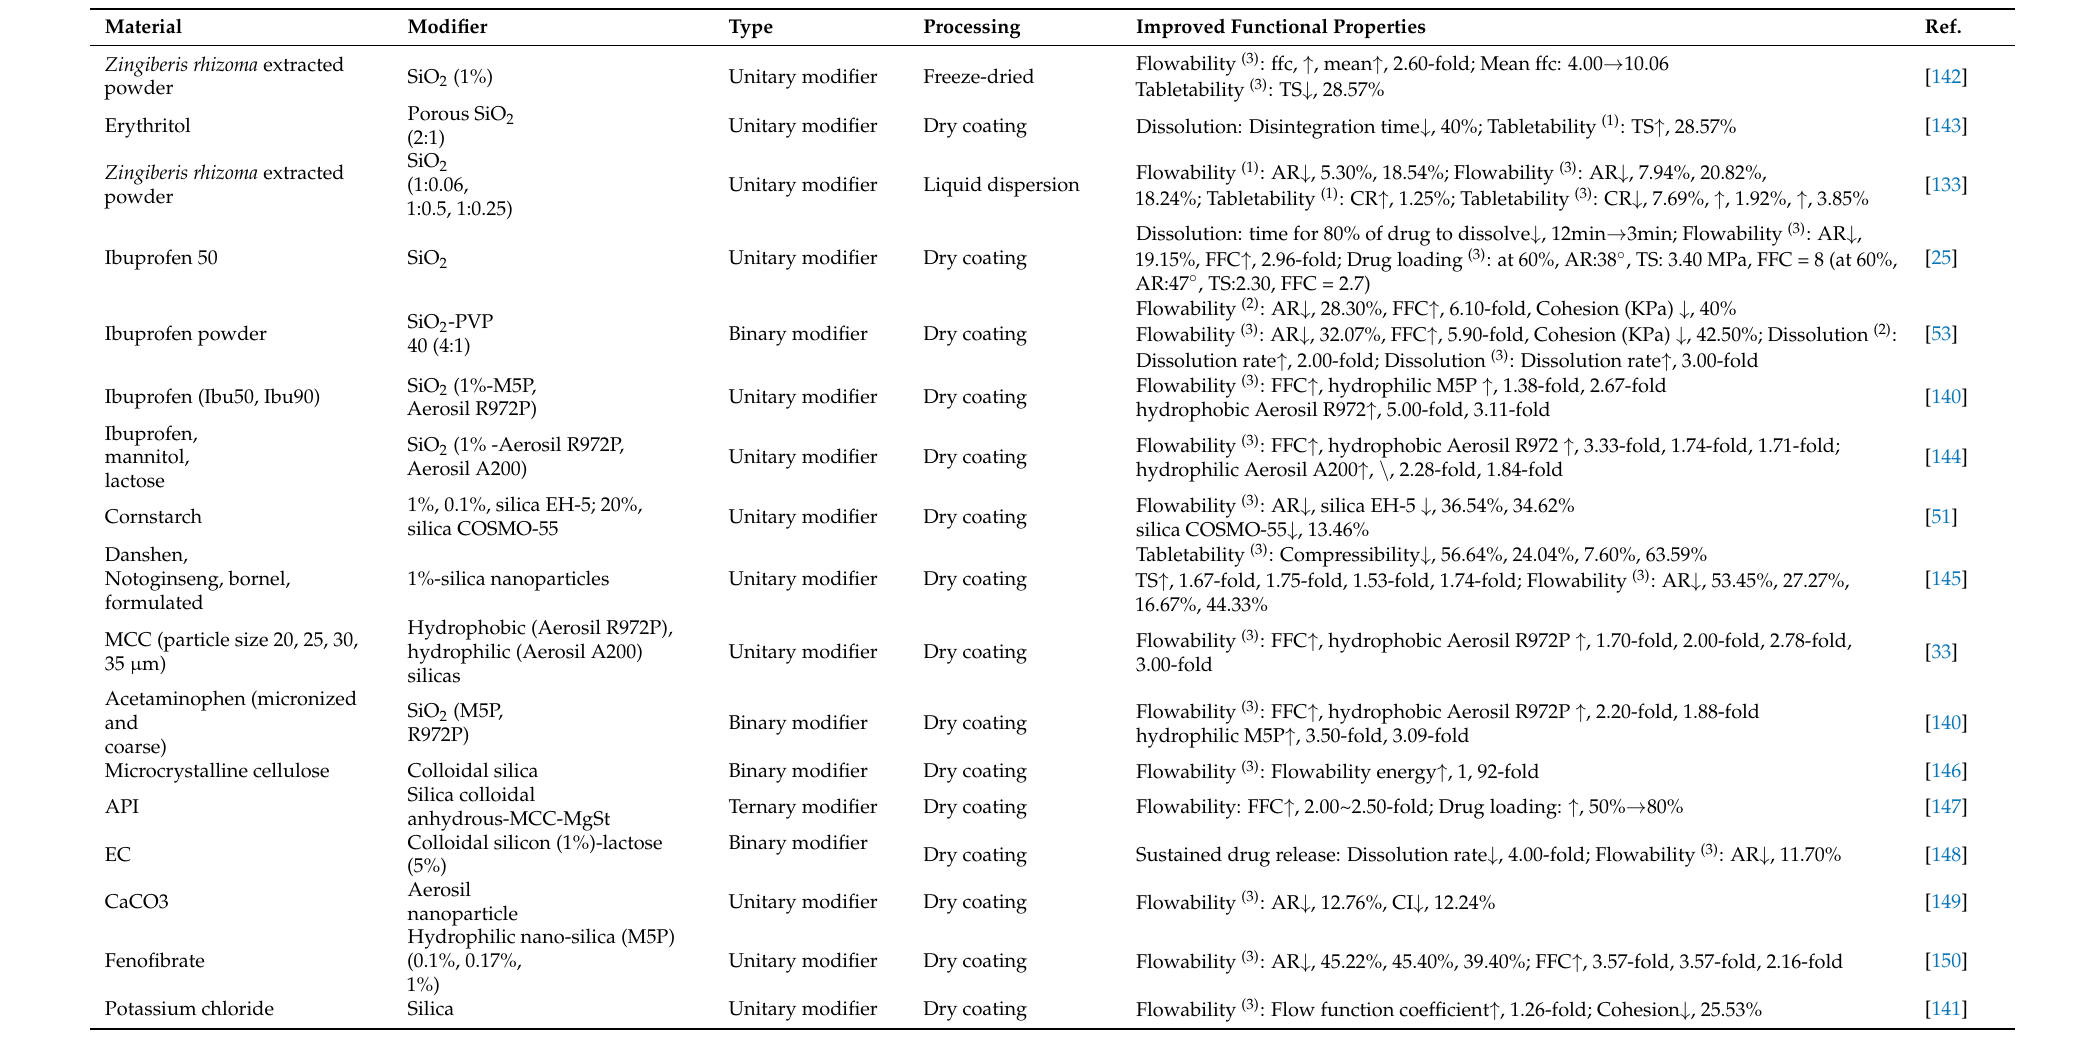
Table 3. The application of SiO 2